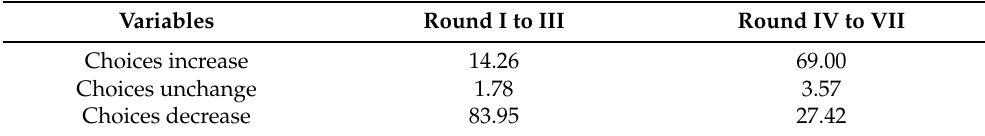
Table 2. Change of agents’ choices ( N = 4200).